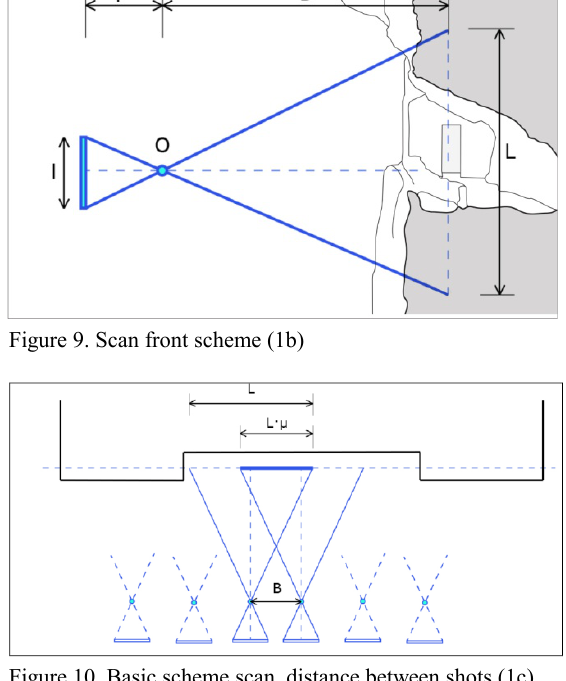
Figure 10. Basic scheme scan, distance between shots (1c)